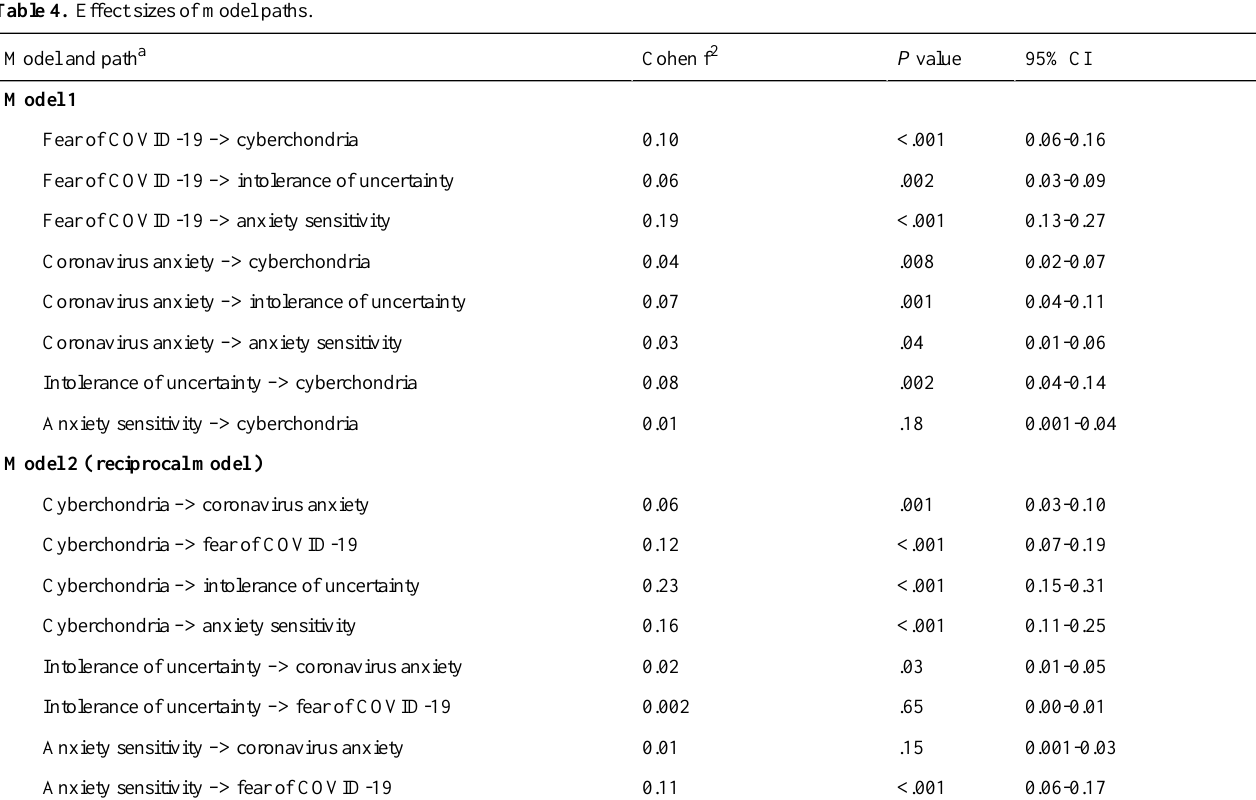
Table 4. Effect sizes of model